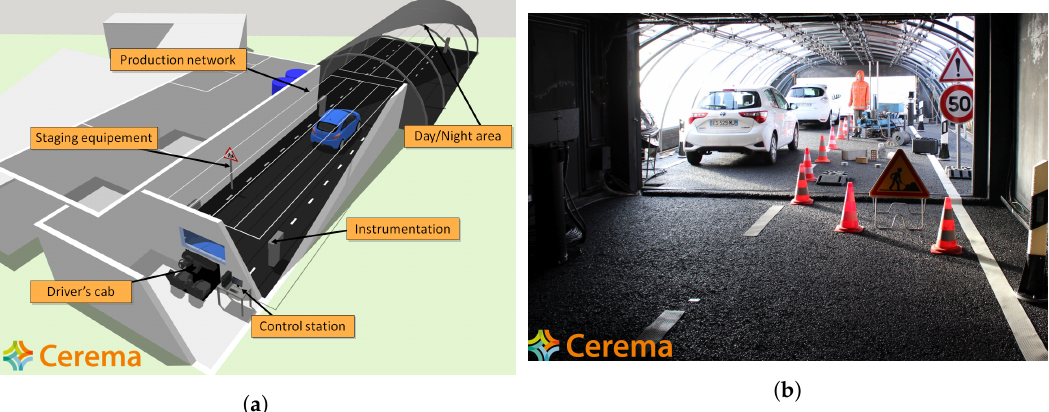
Figure 5. The PAVIN BP platform. ( a ) Exploded diagram of the infrastructure, presenting the 3 parts: the observation post, the tunnel section for night conditions, and the greenhouse section for day conditions; ( b ) day view with cars, work zone, and various signaling